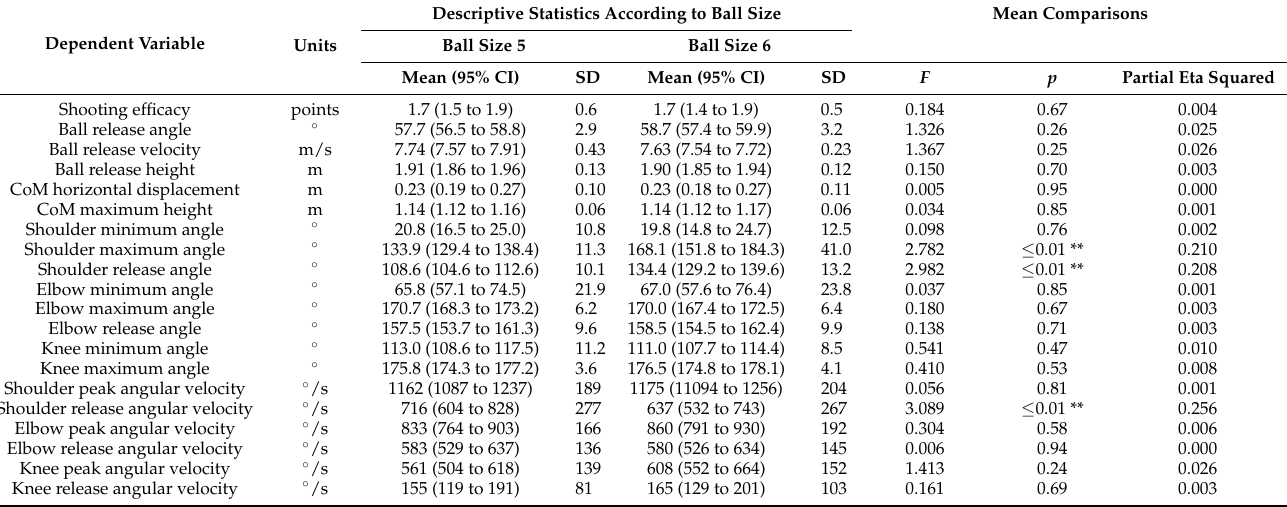
Table 2. Descriptive statistics and MANOVA results to examine mean differences for kinematic variables obtained in 5.75 m basketball shooting with ball size five and ball size six among female adolescent basketball players (n =